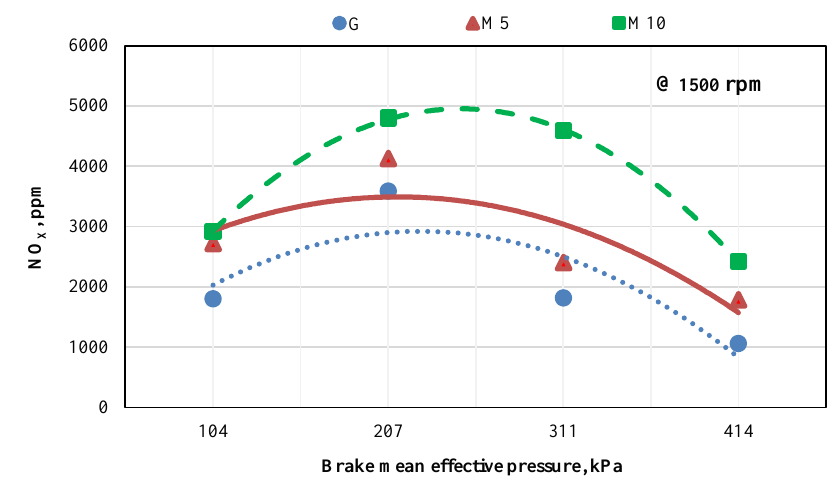
Fig. 9. NO x emission for tested fuels at different